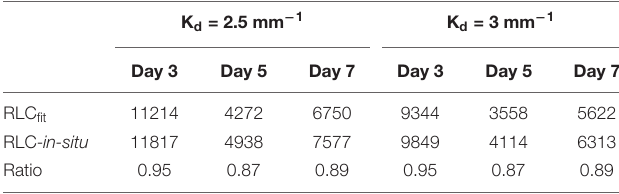
TABLE 2 | Total depth integrated relative photosynthetic electron transport rates (relative units) for the low tide period shown in days 3, 5, and 7 ( Figure 5 ). K d = 2.5 mm − 1